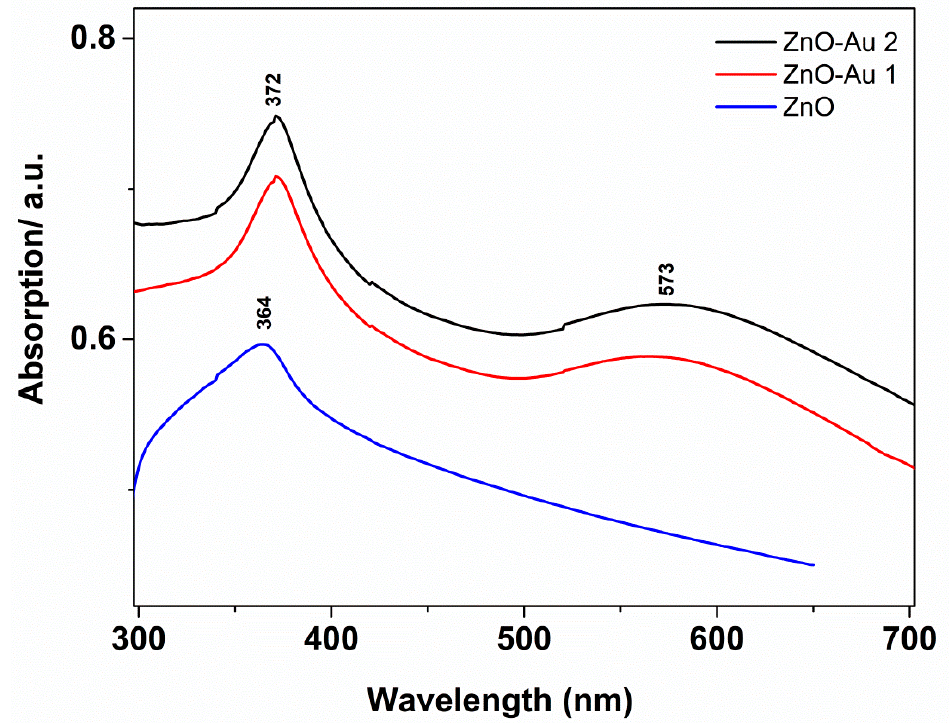
Figure 7. UV-Vis spectra acquired from ZnO nanoparticles and the ZnO-Au nanocomposites, re- spectively.